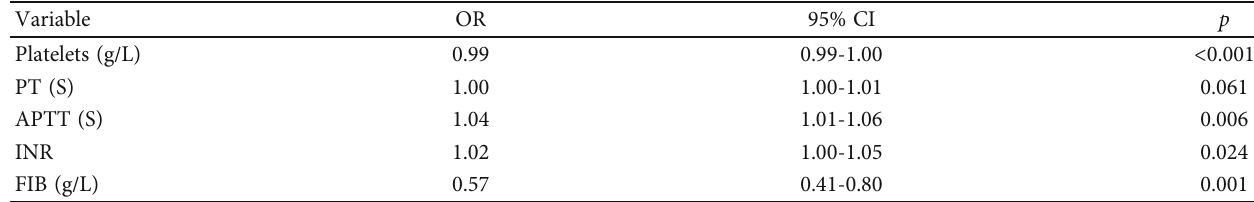
Table 3: Univariate logistic